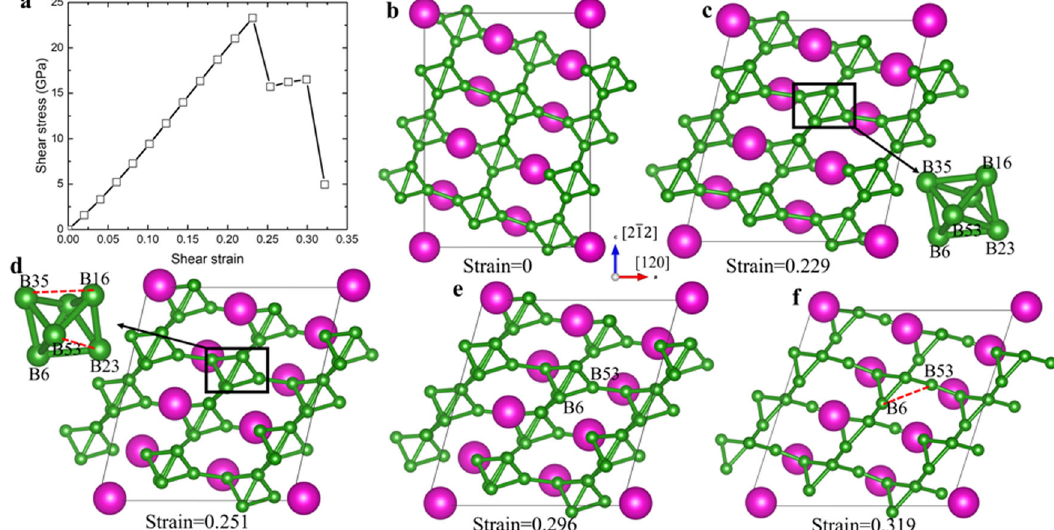
-- Fig. 5 The failure process of EuB 6 under biaxial shear deformation along (2 12)[120] slip system. a The shear-stress-shear-strain relationship. b – e The failure process: b the intact structure; c the structure at 0.229 strain with ideal strength; d the structure at 0.251 strain in which B35-B16 and B23-B53 bond within octahedron break; e the structure at 0.296 strain; f the structure at 0.319 strain after structural failure. The B53-B6 bond within octahedron Fig. 12. At 0.09 tensile strain, some octahedra (labeled as rectangles) are completely deconstructed. Meanwhile, the Eu4 and Eu7 atoms move away from their original positions. This